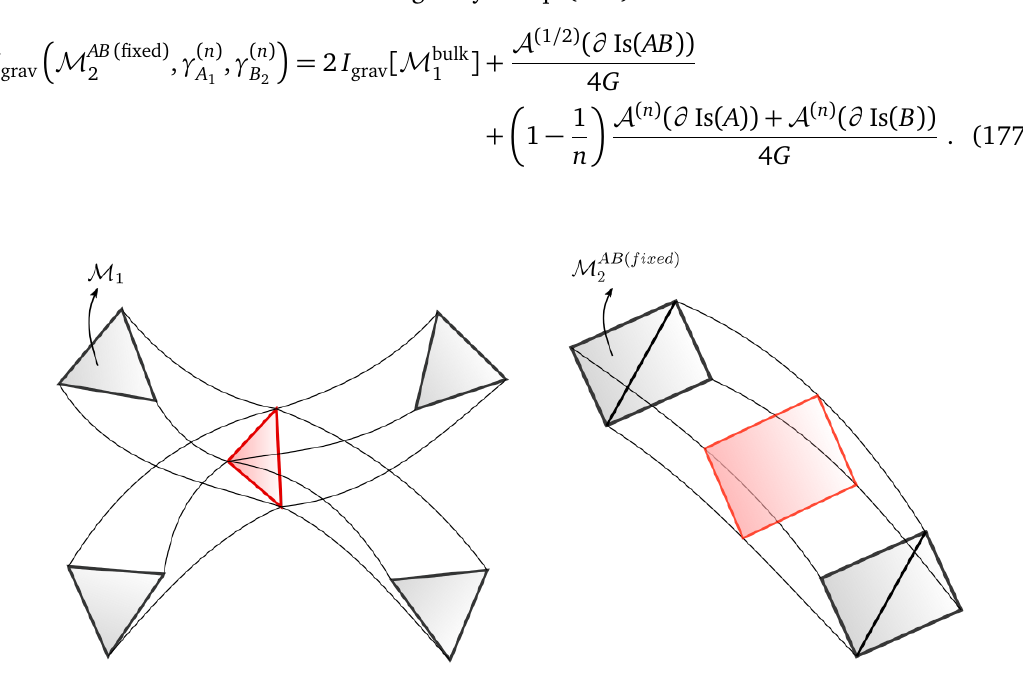
Figure 28: A cartoon picture of the replica wormhole saddle for the gravitational path ( bulk ) ] on the left and (cid:90) [ M A , B ( bulk, nsym ) integral for (cid:90) [ M AB 2 n for n =